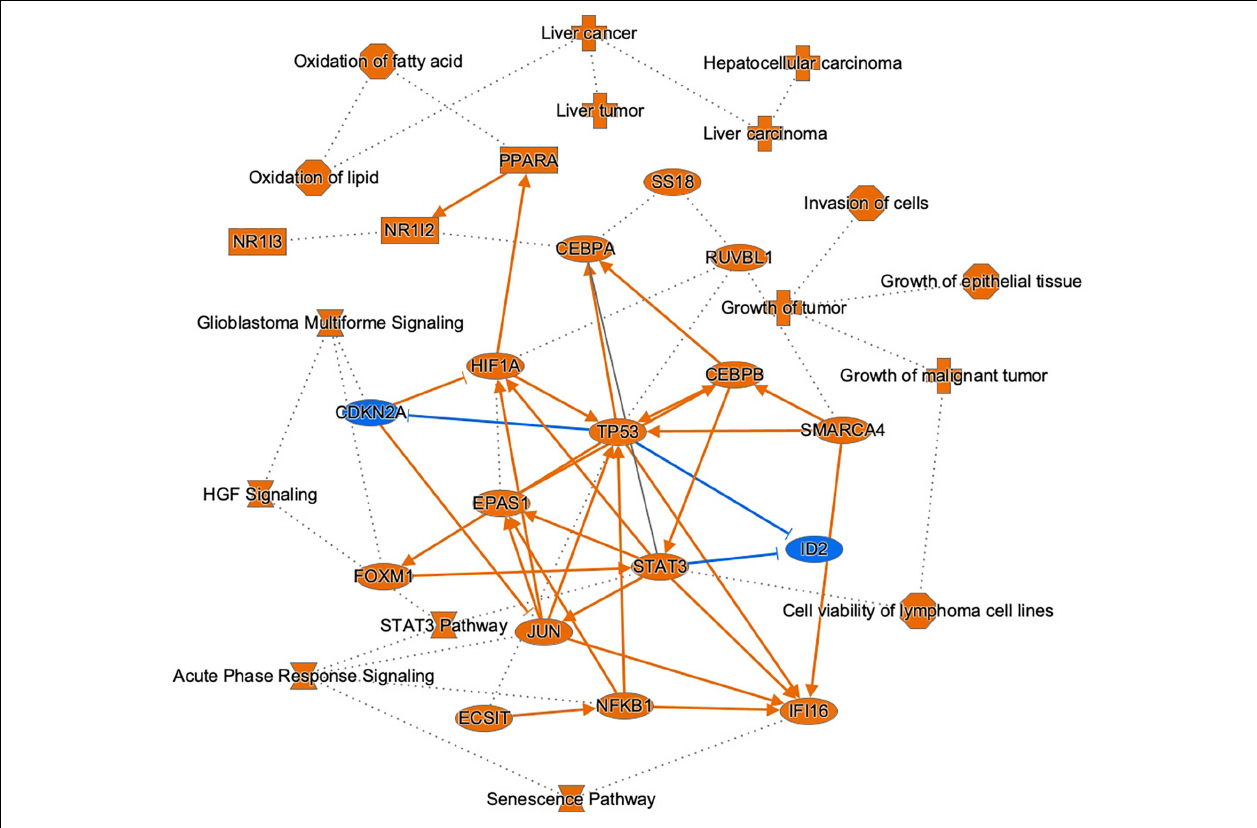
FIGURE 8 | Graphical summary of molecules, pathways, and functions regulated by integrating DNAm-miRNA-mRNA interactions in HCC. This network mostly represents the highly rated interactions of genes, pathways and functions found to exhibit this form of complex regulation. Selected target genes of differentially methylated and differentially expressed miRNAs in HCC are depicted (blue = downregulated, orange = upregulated), as well as top pathways and functions associated with these molecules. A solid line represents a direct interaction between the two gene products and a dotted line means that there is an indirect